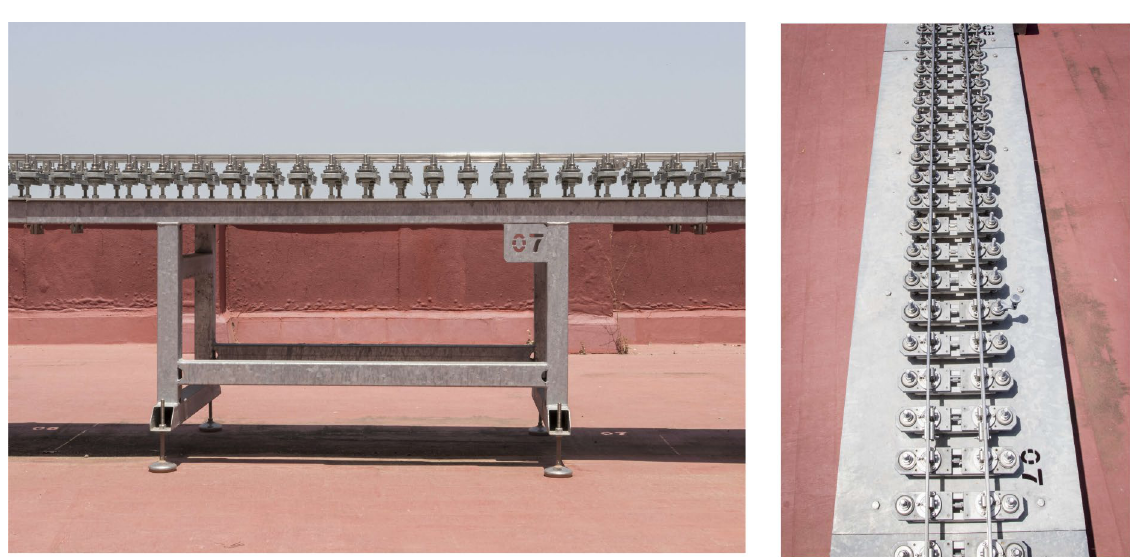
Figure 9. Table support structure: elevation view (left); horizontal view (right). Photographer: Ludivine